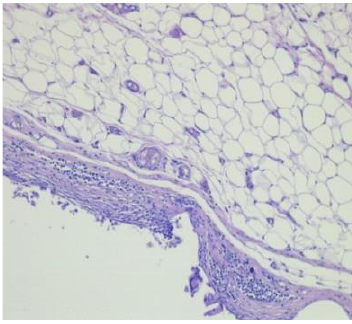
Figure 7. Low inflammatory infiltrate at six weeks after surgery.